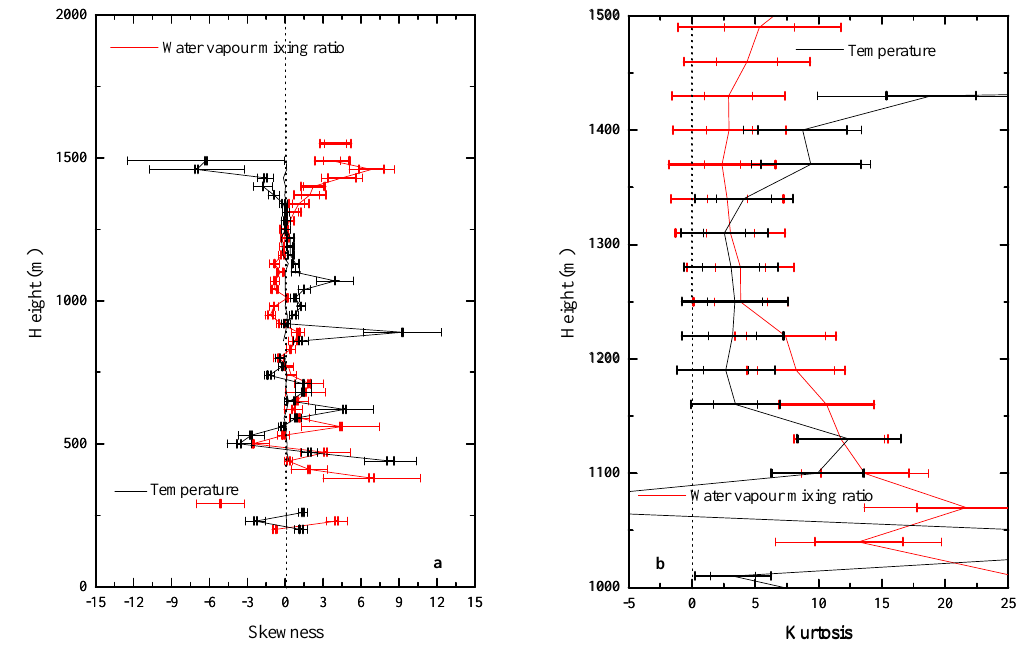
Figure 13. Vertical profiles of skewness (a) and kurtosis (b) for water vapour mixing ratio and temperature computed for the same time interval considered in Fig. 4. In the figure the thick error bars represent the noise error, while the thin error bars represent the sampling